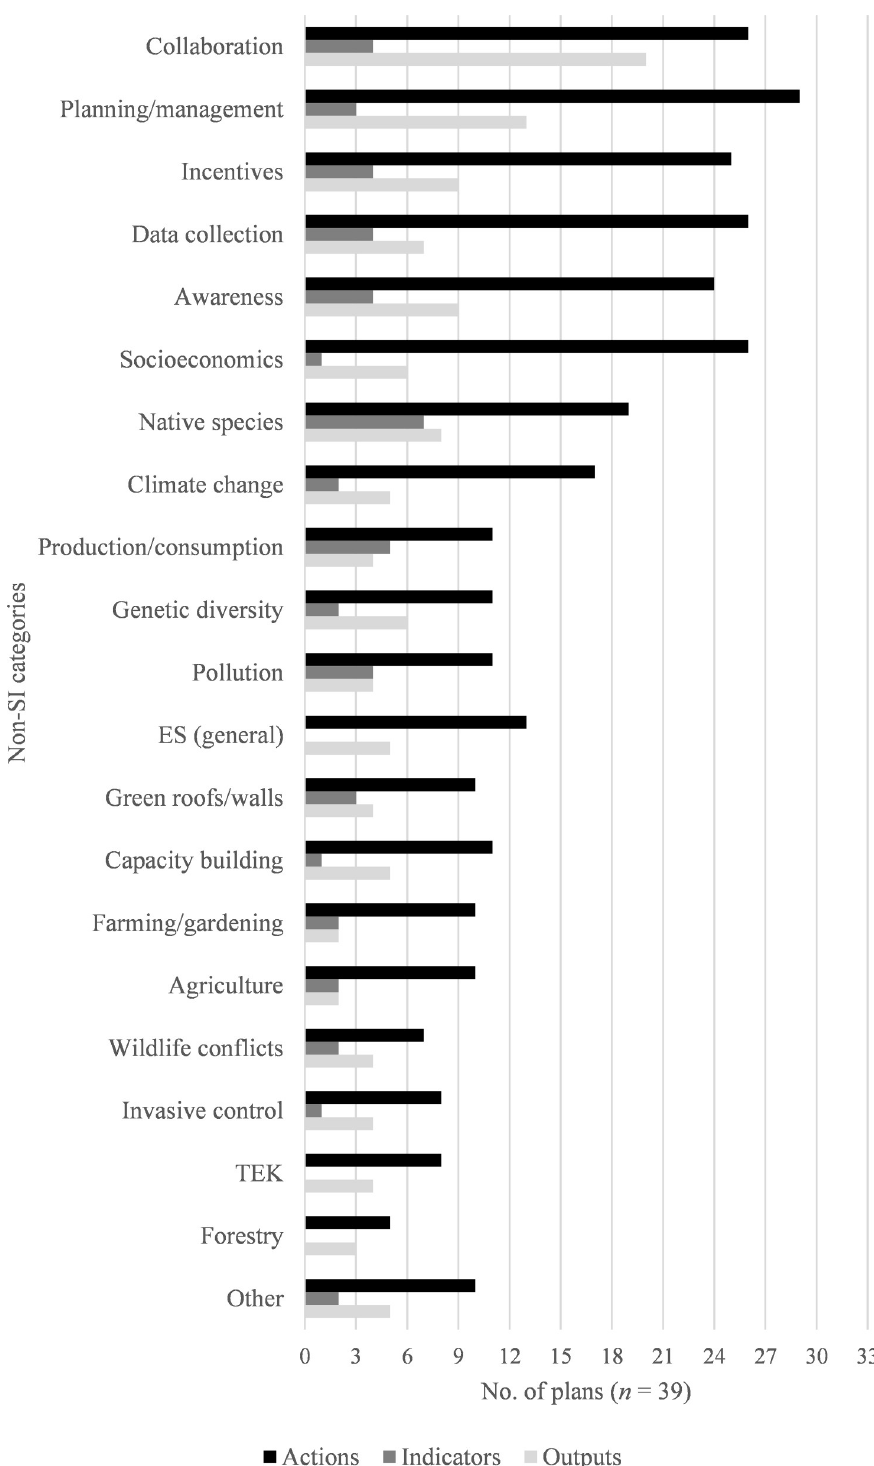
Fig 5. Plan elements classified by inductively derived topic. Chart of the categories for all plan elements that were classified according to inductively derived topics once it was determined that they could not be classified according to the SI framework. “Native species” here refers to plan elements related to native species other than species count indicators. ES, ecosystem services; TEK, traditional ecological knowledge.